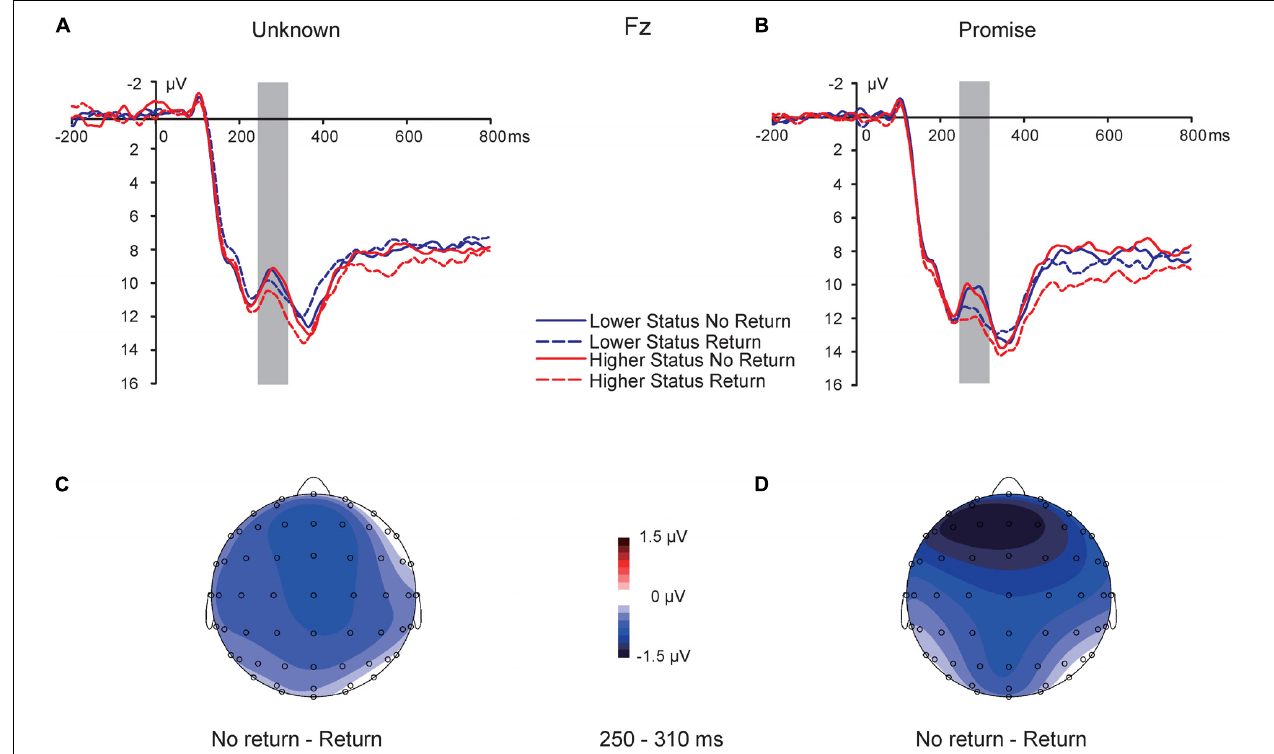
FIGURE 3 | Medial frontal negativity (MFN). ERP response time-locked to the onset of the TG return feedback at the Fz electrode in the “unknown” (A) and “promise” (B) conditions. Topographic maps for the MFN effect in the 250–310 ms time window in the “unknown” (C) and “promise” (D)